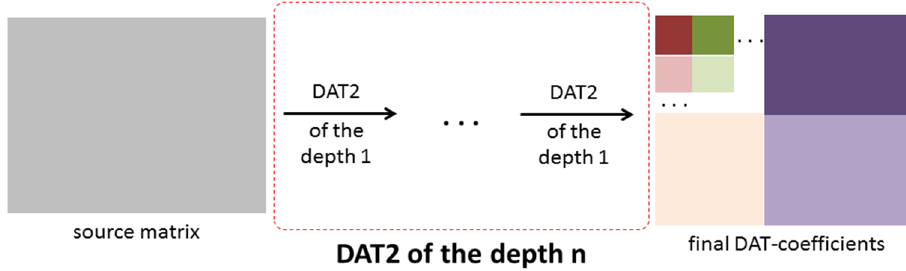
Figure 7. A structure of the matrix transform DAT2 of the depth 1.